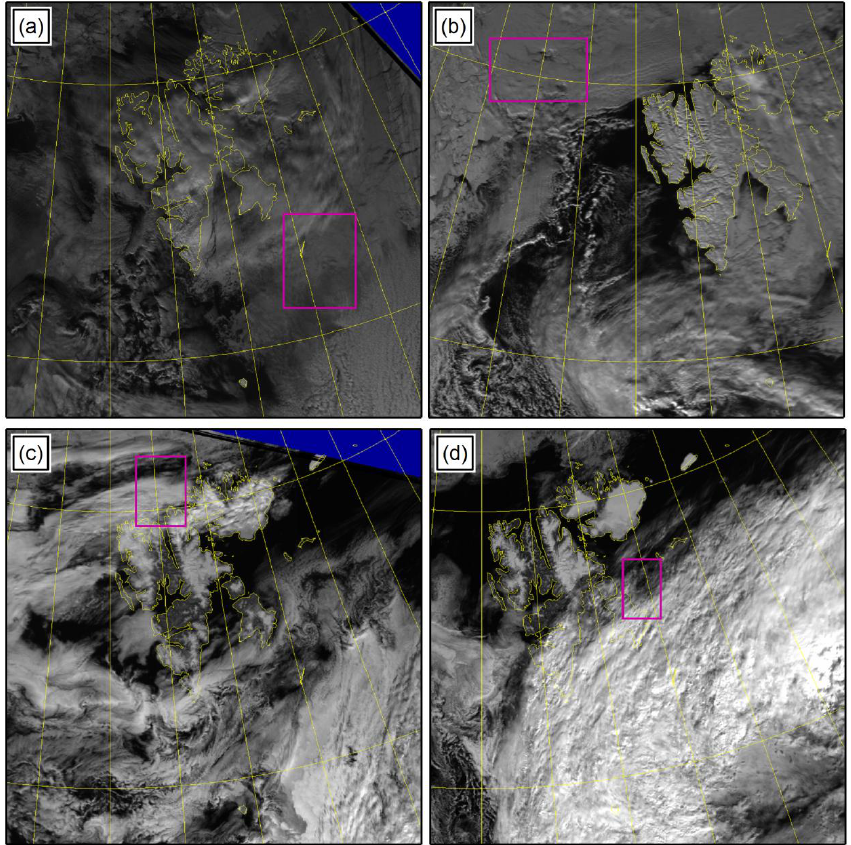
Figure 1. AVHRR visible satellite imagery for spring case 1 (a) , spring case 2 (b) , summer case 1 (c) and summer case 2 (d) . The science flight area is highlighted by purple boxes in each